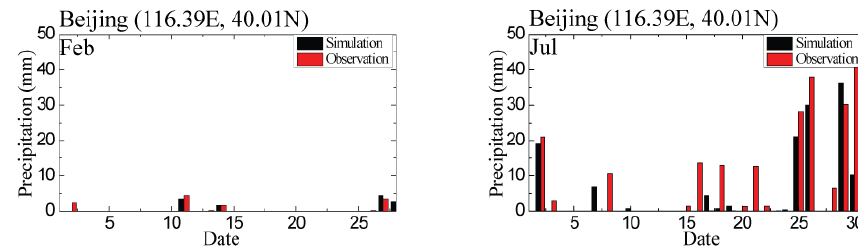
Figure 8. Observed and modeled daily precipitation (mm) in February and July 2011 in Beijing